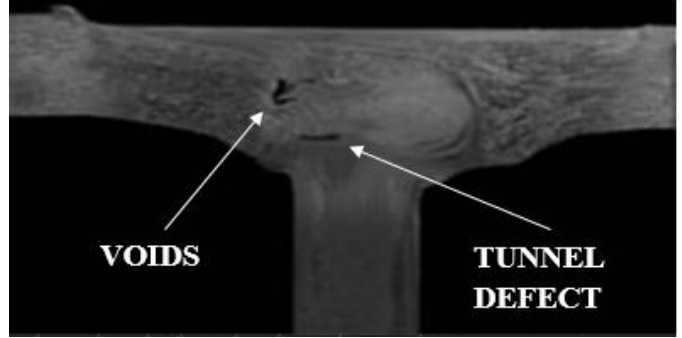
Figure 8. Tunnel and void defect in T-joint.